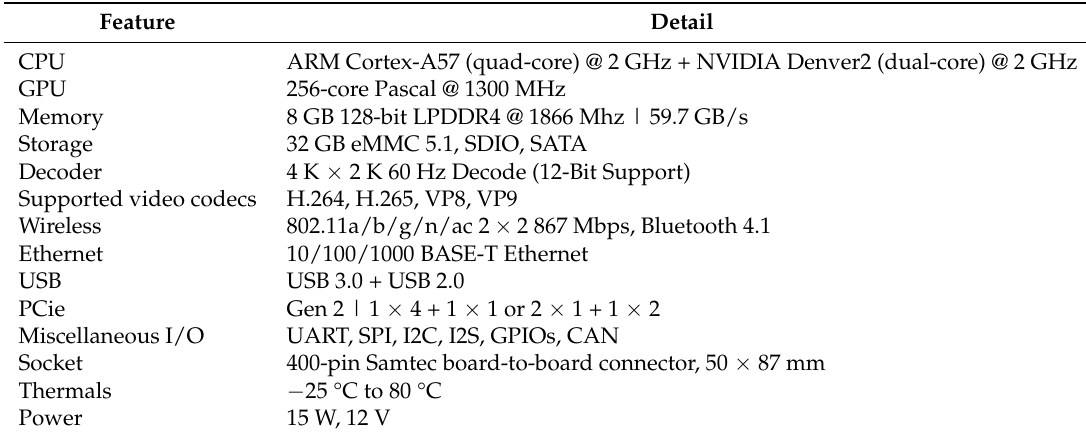
Table A1. Specification of the NVIDIA Jetson TX2.